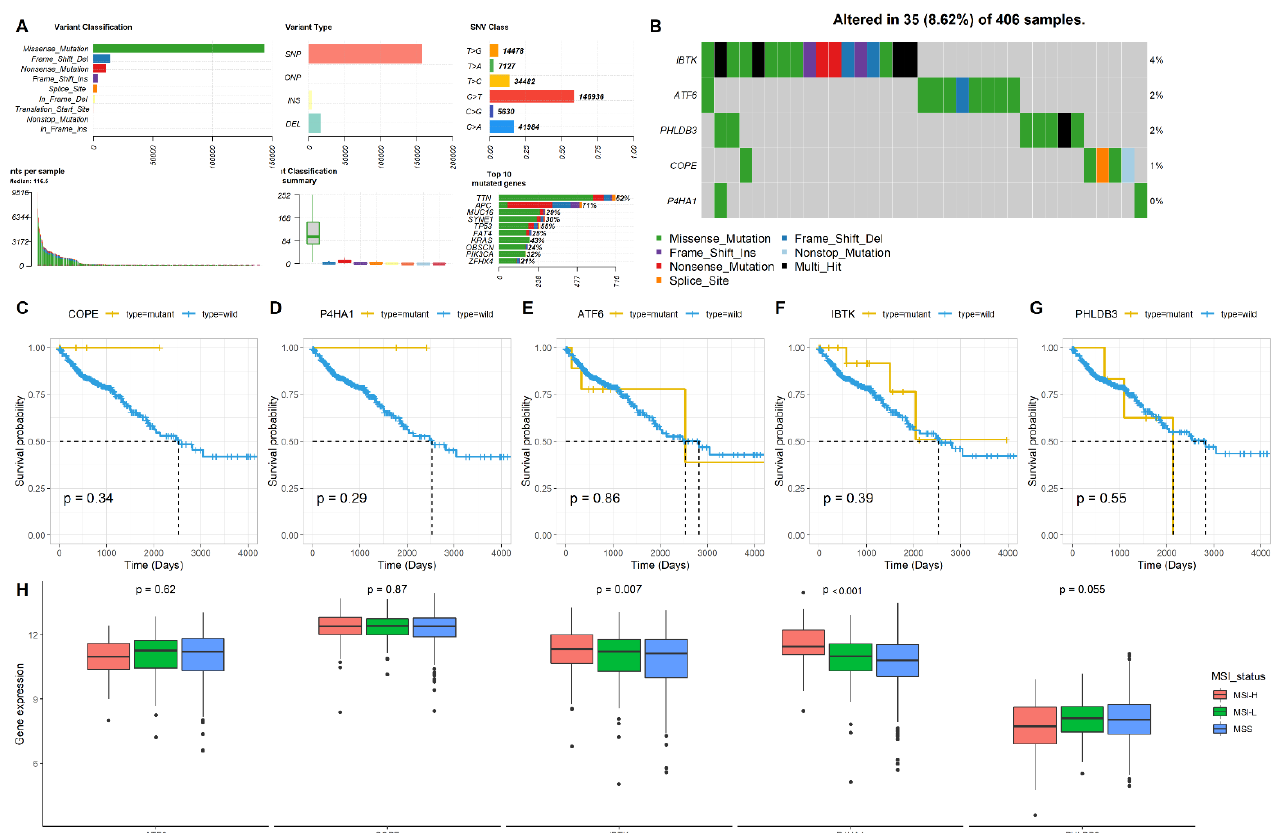
Figure 3. The mutation and MSI status of the five genes in CRC. ( A ) The mutation landscape of genes in CRC; ( B ) the mutation landscape of the five genes in CRC; ( C – H ) the association of the five genes’ mutations with the survival of CRC patients; ( H ) Association of the five genes’ expressions with the MSI status of CRC patients.